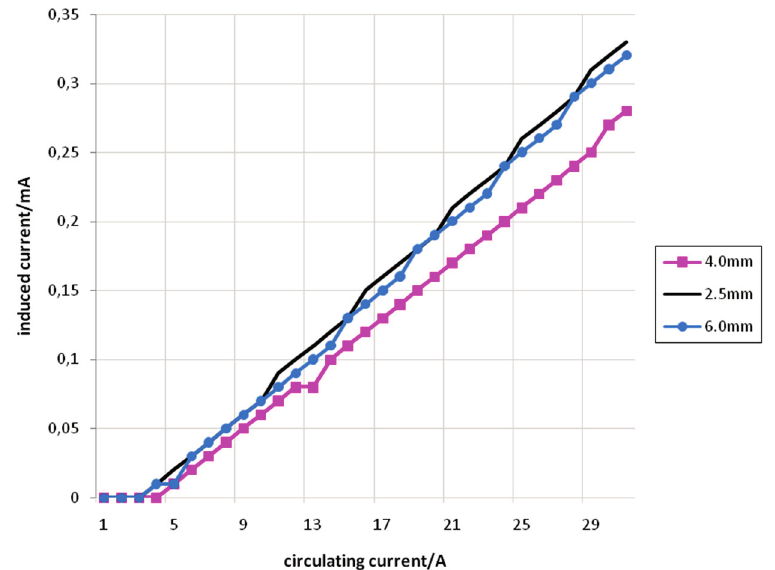
Figure 12. I f versus I i for 10 turns with conductors of 2.5 mm 2 (black), 4 mm 2 (pink), and 6 mm 2 (blue).